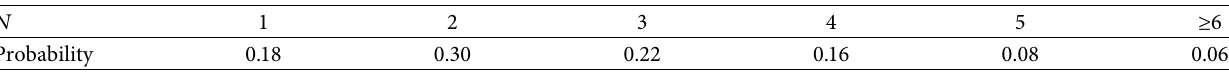
Table 3: The reference distribution of the number of family members N from Chinese statistical yearbook of 2020. N 1 2